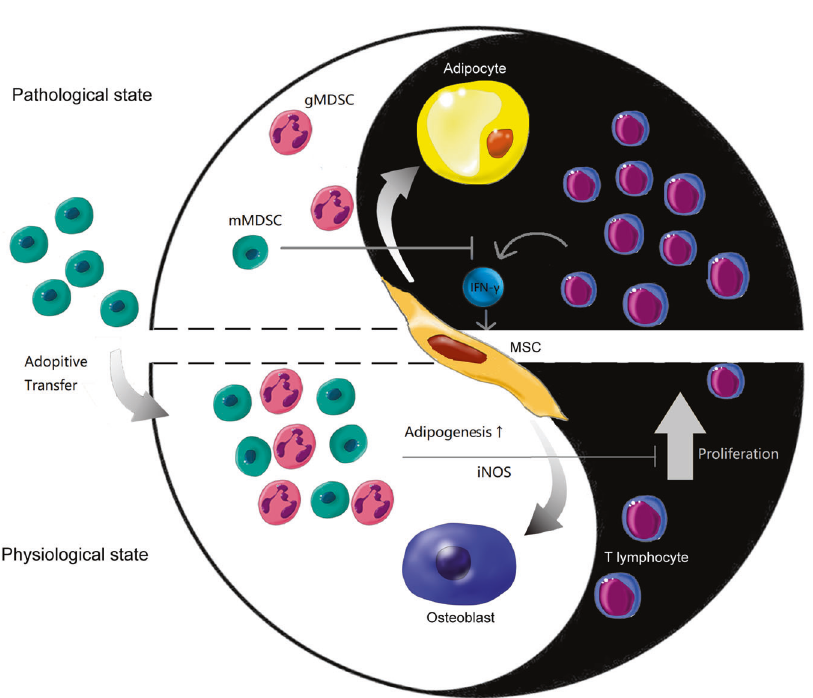
Fig. 8 Effect of Yin (intra-BM immune over-activation) and Yang (intra-BM immune-modulation) on MSC differentiation within BM microenvironment. In AA BM, T cells (especially CD8 + T cells) are over-activated by AA-relating irritators, resulting in a Th1 immune response and increasing secretion of IFN- γ . In fl ammatory IFN- γ licensed BM-MSCs shift their osteo-adipogenic differentiating potential towards adipogenic lineage which barely be able to support hematopoiesis. Reconstitution of the balance in BM microenvironment by immune modulating cells consequently improves microenvironment which is required for normal